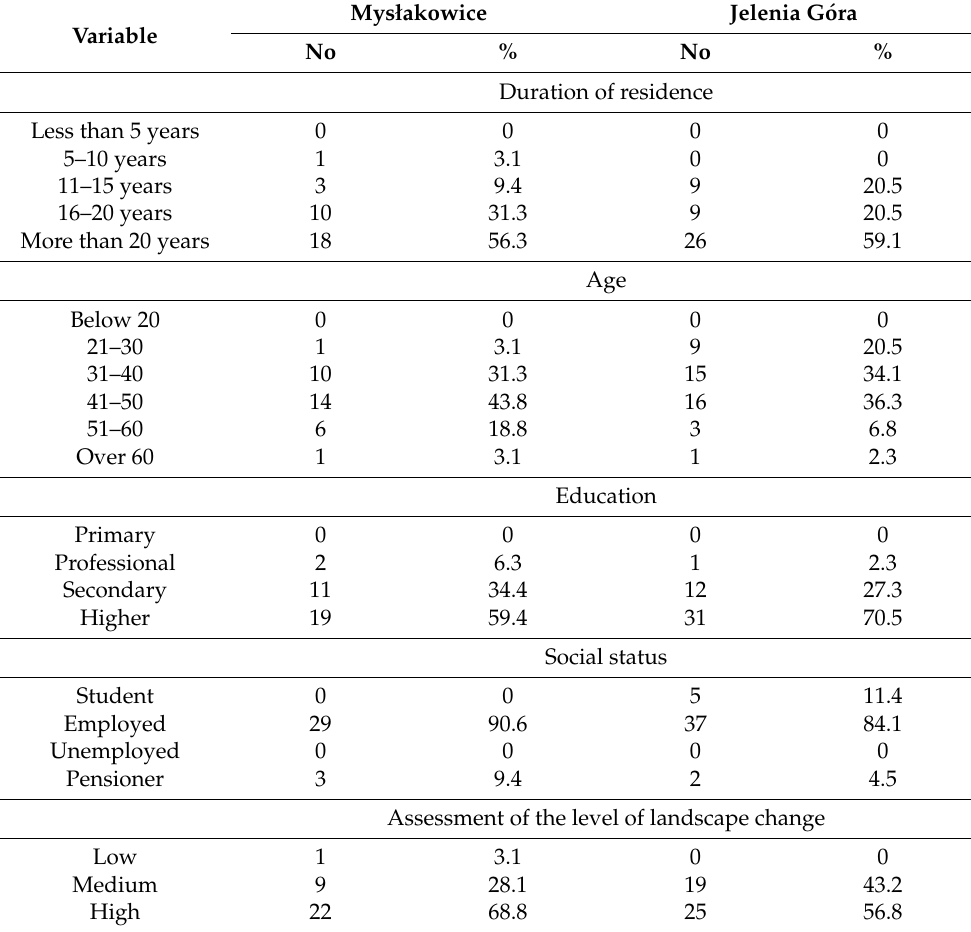
Table 4. Demographic characteristics of the survey